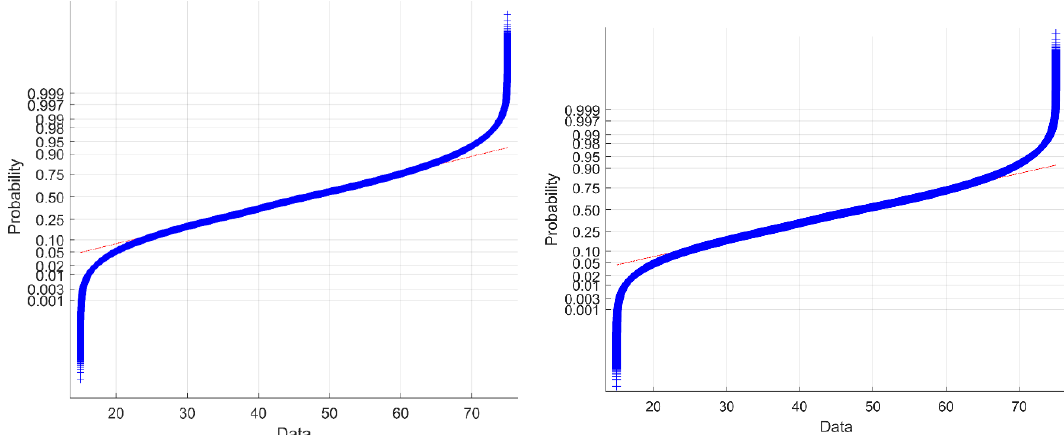
Figure 7. Normal probability plots for the snow-covered scenes of February and March 2019 in left and right, respectively. In the plots, the y -axis shows the normal probability and the x -axis refers to the data corresponding to the different values of the local incidence angle observed.